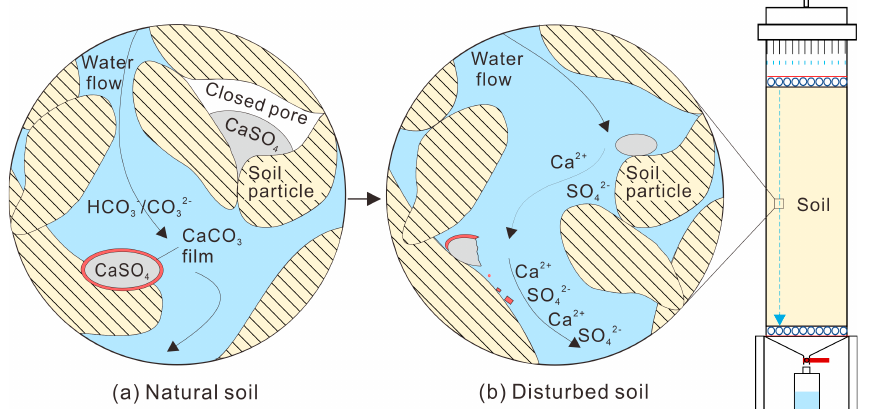
Figure 4. Conceptual diagram of the occurrence of SO 4 -containing evaporites and rock-water interac- tion mechanisms in the disturbed soil; ( a ) the location of SO 4 -containing evaporites which are not dissolved by water flow in the natural soil; and ( b ) SO 4 -containing evaporites’ dissolution in the disturbed